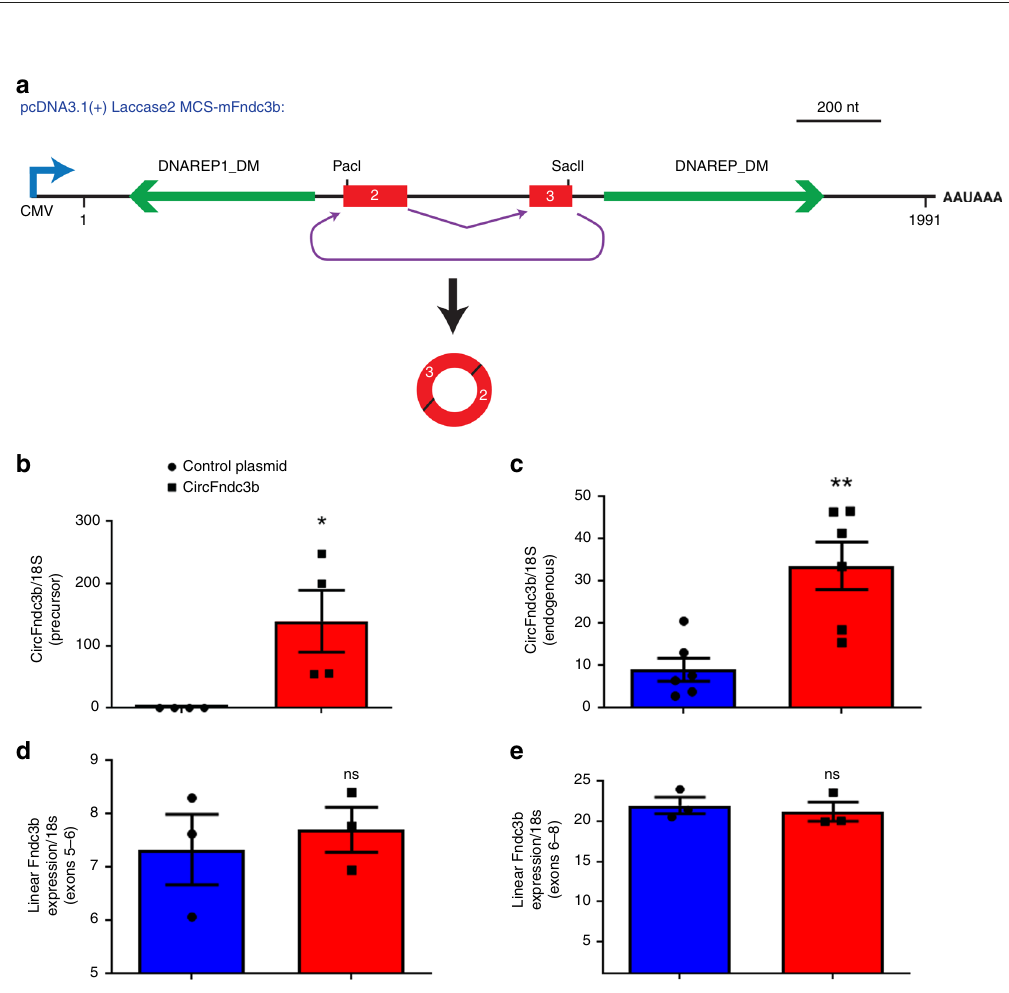
Fig. 2 Generation of circFndc3b overexpression plasmids: a Exons 2 and 3 of the mouse Fndc3b gene were inserted between the laccase2 fl anking introns, which harbor inverted DNAREP1_DM repeat sequences that promote back splicing. PacI and SacII sites were included within the Fndc3b exons to allow plasmid-derived circFndc3b to be distinguished from the endogenous circRNA. RT-qPCR analysis of precursor-circFNDC3b b and endogenous circFndc3b c expression in control plasmid or circFndc3b overexpression plasmid-treated mouse cardiac endothelial cells, normalized to 18S rRNA. Data are Mean ± SEM of four independent experiments/group. * p < 0.05, ** p < 0.01 vs control plasmid (two-sided unpaired students t -test). d , e RT-qPCR analysis of linear Fndc3b mRNA levels in control plasmid or circFndc3b overexpression plasmid-treated cardiac endothelial cells, normalized to 18S rRNA. Data are Mean ± SEM of four independent experiments/group. Not signi fi cant (ns) vs control plasmid (two-sided unpaired student ’ s t-test). The round dots represent control plasmid and square denotes circFndc3b pathophysiology. Therefore, we tested if exogenous delivery of (Fig. 4b) with the appropriate splicing junctions (Supplementary circFndc3b may attenuate LV remodeling and dysfunction post- Fig. 3B). In addition, endogenous circFndc3b levels increased in MI in mice. We generated AAV9 viral particles that express the LV tissue compared to controls 8 weeks post-MI in mice circFndc3b under control of a CMV promoter (Fig. 4a) and intra- (Fig. 4c). Like was observed in vitro (Fig. 2d, e), expression of the myocardially injected 1 × 10 12 vp/ml AAV9 circFndc3b or an Fndc3b linear mRNA was unchanged upon circFndc3b over- AAV9 control immediately post-LAD ligation. RT-PCR con- expression (Fig. 4d, e). We then determined the effect on LV fi rmed that the AAV9 vector generated mature circRNAs function by echocardiography in mice injected with either AAV9